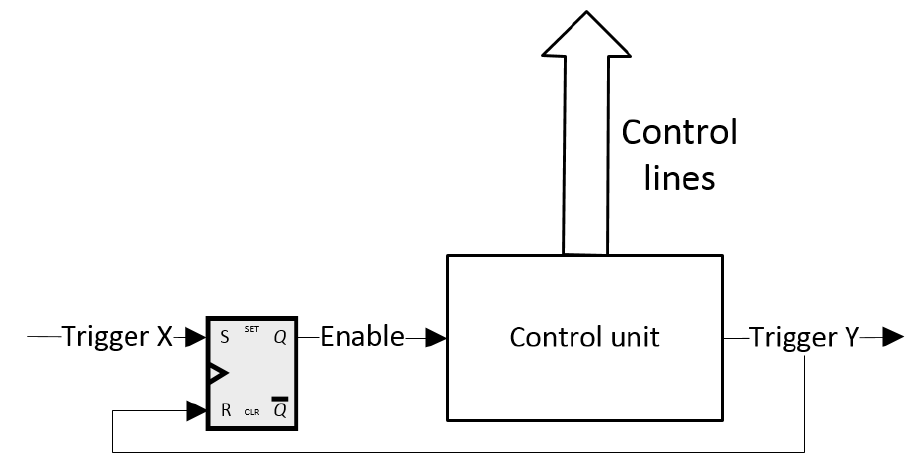
Figure 6. Enabling and disabling the control system in the decoder